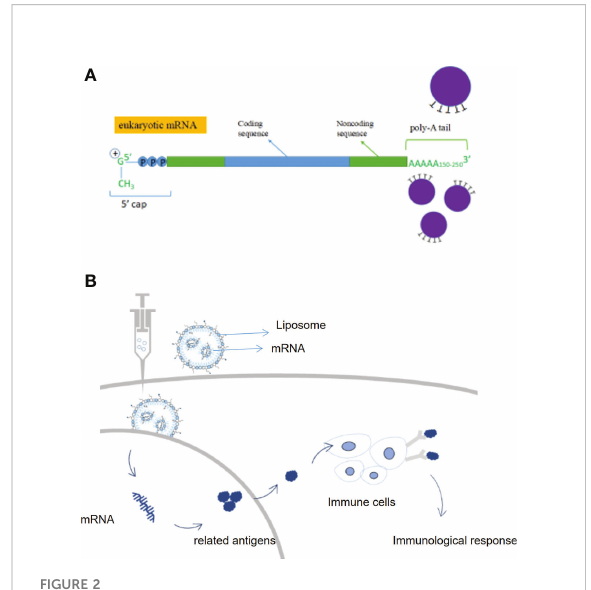
FIGURE 2 Structure and therapeutic principles of mRNA drugs. (A) Key structures of mRNA products, (B) Mechanism of action of mRNA